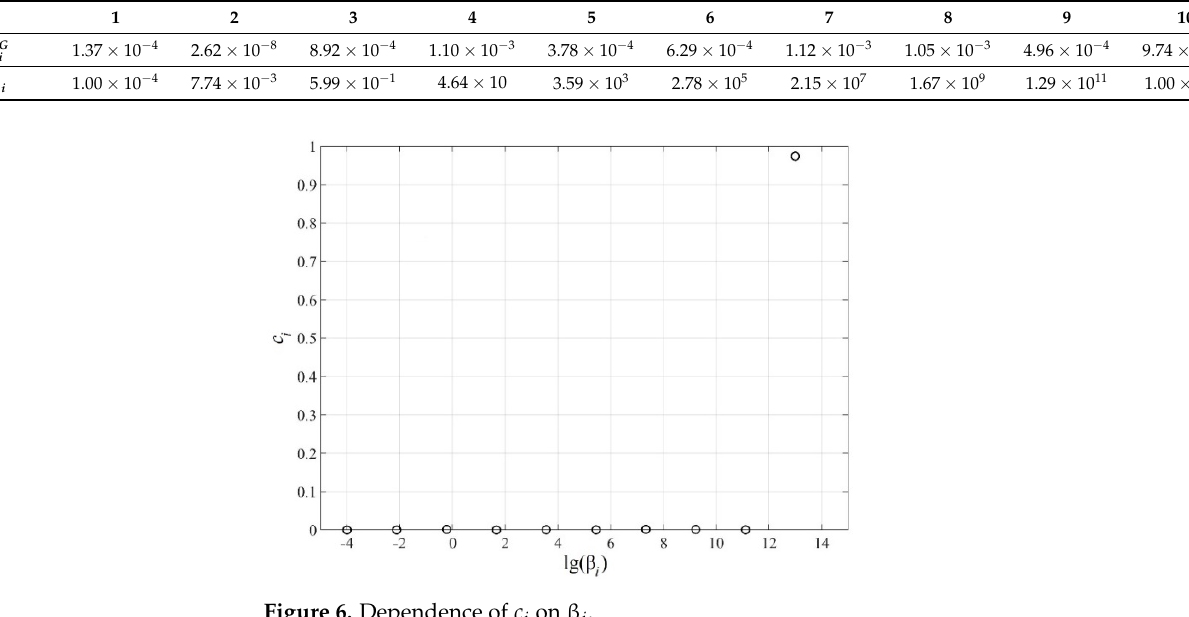
Table 6. Values of constants of the Williams–Landel–Ferry shift function.